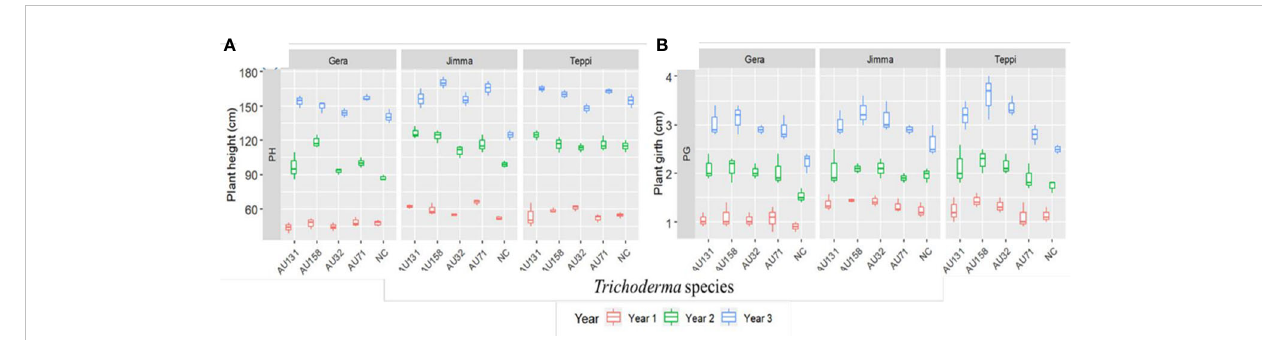
FIGURE 12 Boxplots of Geisha coffee plant growth after treatment with Trichoderma WP under fi eld conditions. (A) Plant height and (B) Plant girth. Trichoderma isolates: T. longibrachiatum AU32, T. asperellum AU71, T. asperellum AU131, T. longibrachiatum AU158, NC, Negative Control; Year 1 = 2018/19, Year 2 = 2019/20 and Year 3 = 2020/21. The boundaries of the boxplot indicate the 25 th and 75 th percentiles, and the solid line within the boxes indicates the median value.